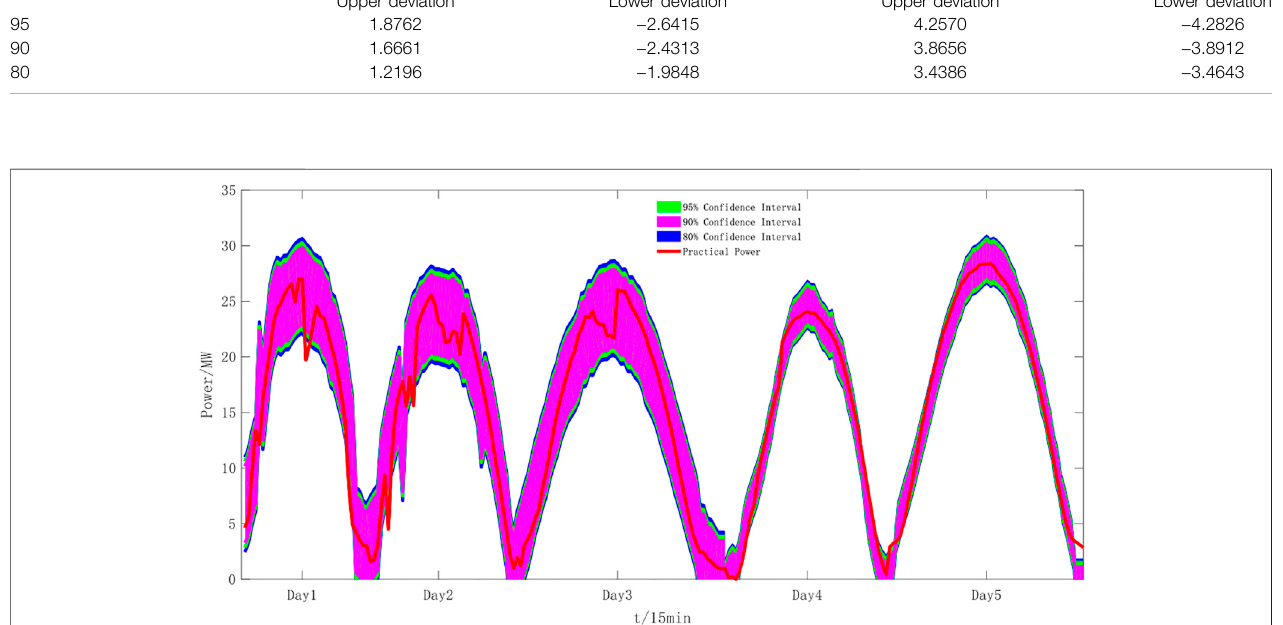
FIGURE 8 | Comparison of fi tting effects of fi ve error distribution